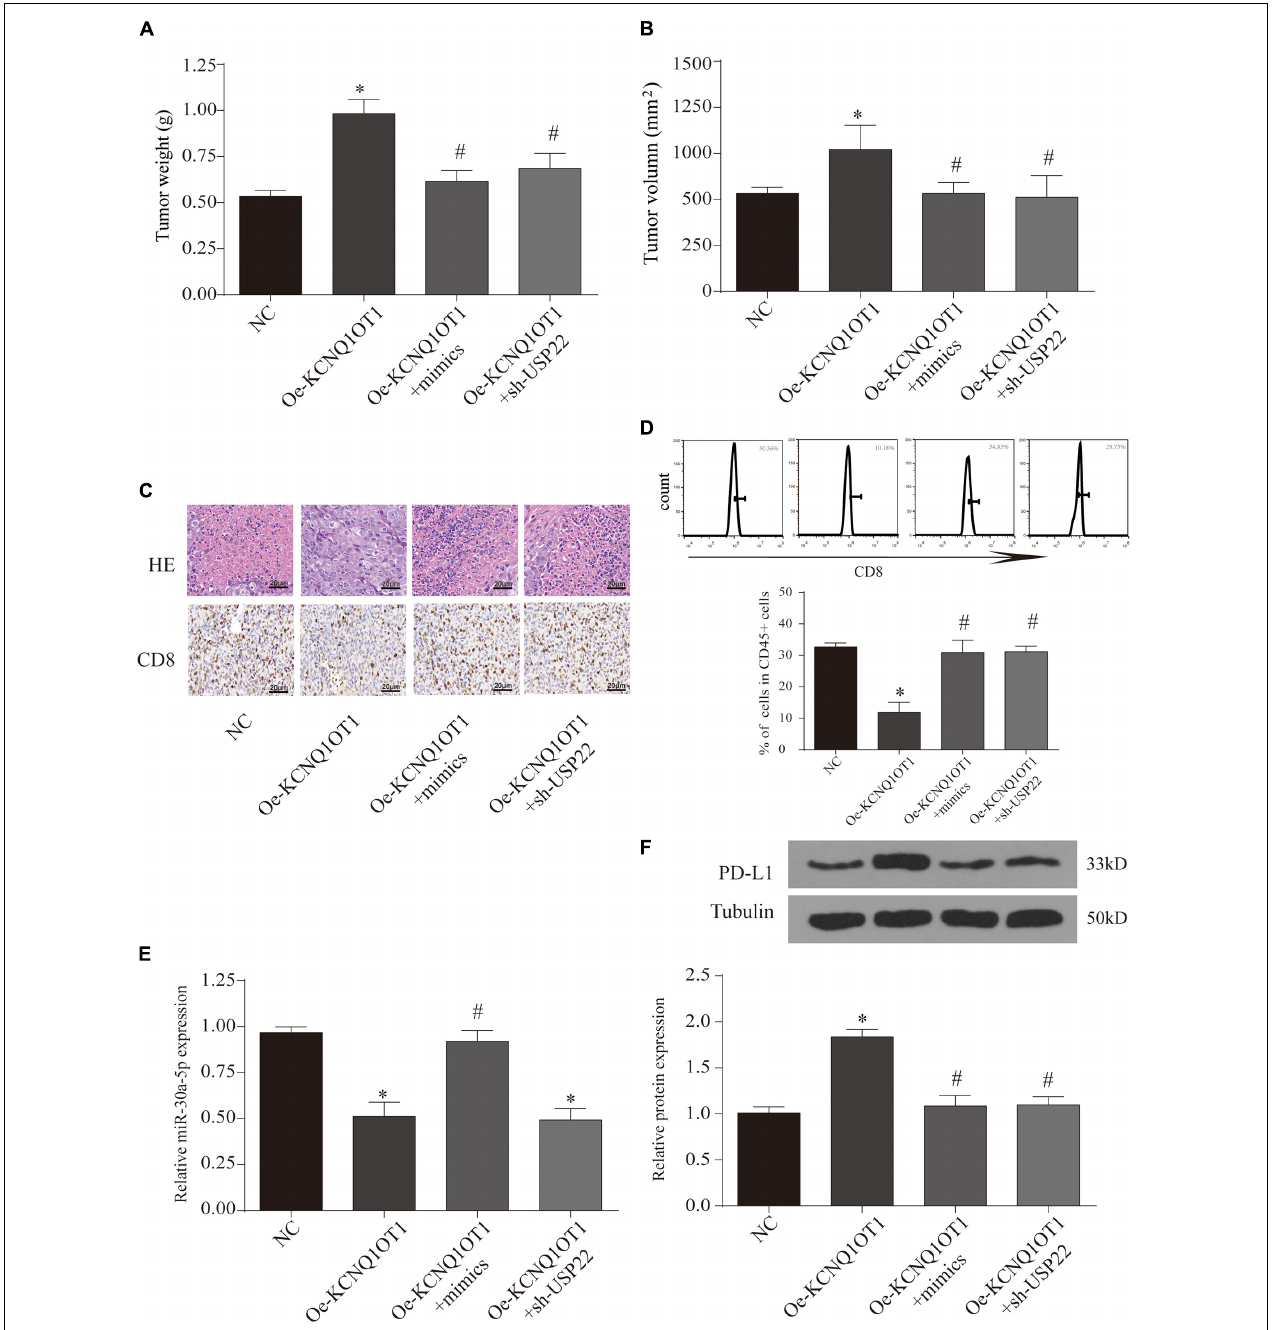
FIGURE 9 | Long non-coding RNA (lncRNA) KCNQ1OT1 regulates tumor cell immune escape via miR-30a-5p/ubiquitin-specific peptidase 22 (USP22) in the in vivo assay. (A,B) Tumor size and weight after different treatments in BALB/c mice. (C) Hematoxylin–eosin staining and CD8 immunohistochemical staining were used to detect tumor proliferation and immune escape in different groups. (D) Flow cytometry is used to detect the content of CD8+ T cells in tumor tissues. (E) The expression of miR-30a-5p in tumor tissues. (F) Programmed death-ligand 1 (PD-L1) protein expression of tumor tissues in different treatment groups. ∗ p < 0.05 compared with the NC group, # p < 0.05 compared with the Oe-KCNQ1OT1 group, N = 6.